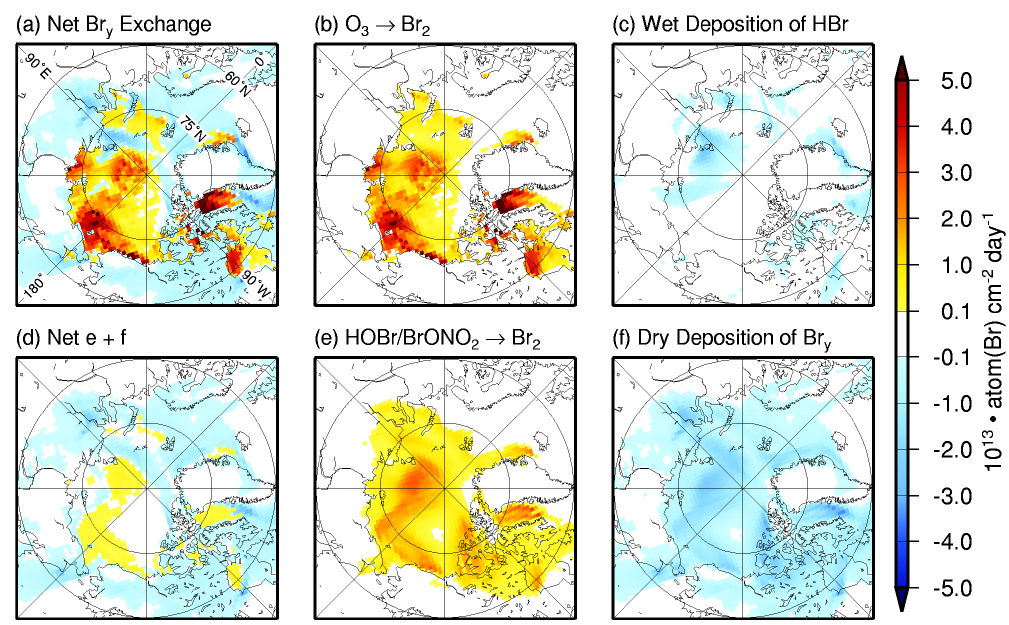
Fig. 15. The net air-surface exchange rate of bromine integrated over 24h between 00:00–24:00UTC on 20 April 2001 as simulated in Run 3 and the separate contribution of each operating mechanism: (a) the total net exchange of all the inorganic bromine species; (b) Br 2 release via dry deposition of ozone on the FY sea ice; (c) wet deposition of HBr integrated over the atmospheric column; (d) the net rate of air-surface bromine exchange via “explosion” chemistry as represented by the sum of (e) and (f) ; (e) Br 2 release via dry deposition of HOBr and BrONO 2 ; and (f) dry deposition of all the inorganic bromine species. Positive values represent a net release to the atmosphere whereas negative values represent a net loss from the atmosphere (in atom (Br)cm − 2 day − 1